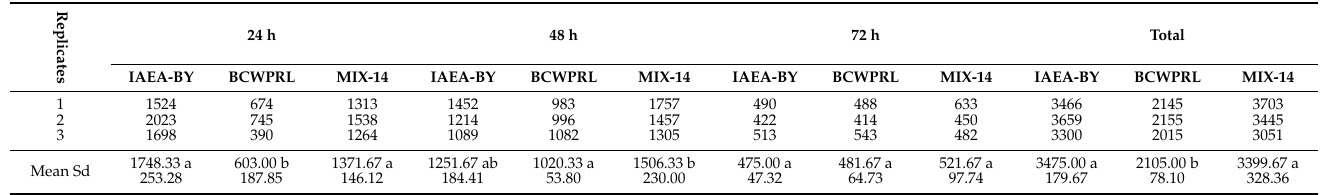
Table 1. The number of pupae collected 24 h, 48 h, and 72 h after the onset of pupation, and the total number of pupae at the end of the experiment for three tested diets.